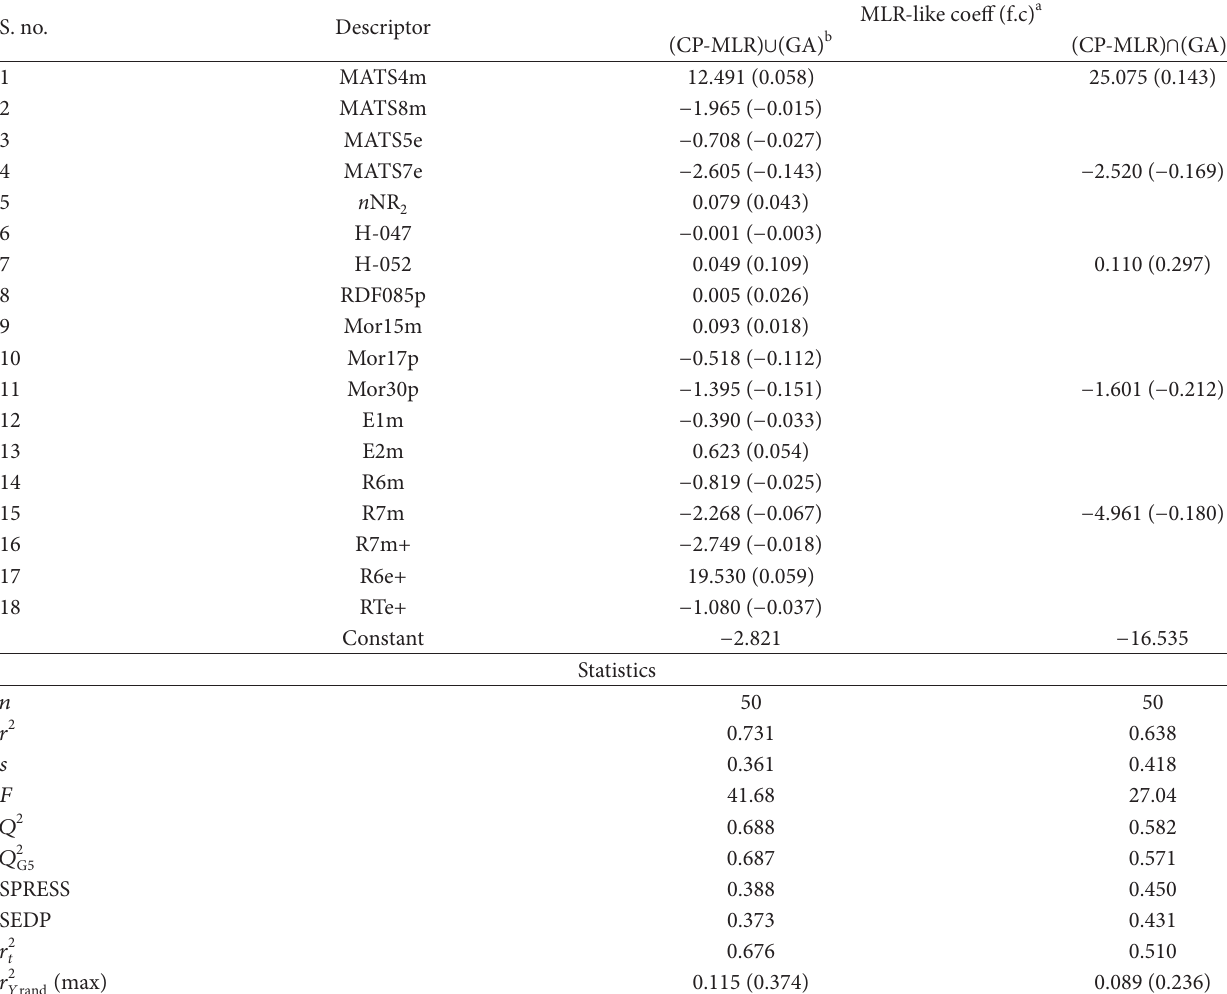
T 5: MLR-like PLS models from the combined as well as common descriptors of CP-MLR and GA approaches (Table 4) for the ) of anilinoquinolines (Table antimalarial activity (pIC 50